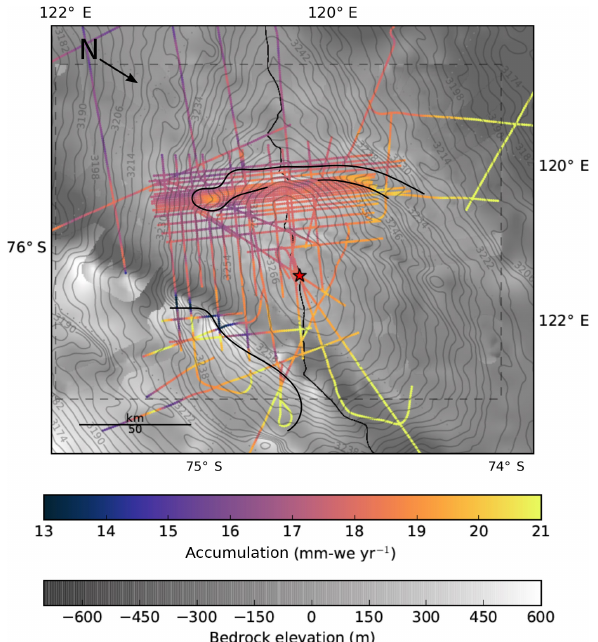
Figure 3. Time-averaged accumulation rates ¯ a along the radar lines over the Dome C region over the last 73kyr. Accumulation rates are given in mm of water equivalent per year. There is a clear large-scale north–south accumulation gradient, with accumulation decreasing with distance from the Indian Ocean coast, the main pathway of snow precipitation. Black lines outline areas of small-scale high ac- cumulation: they correlate to areas where surface contours (in gray) become further apart, i.e., where surface slope is reduced. Back- ground is the same as in Fig.